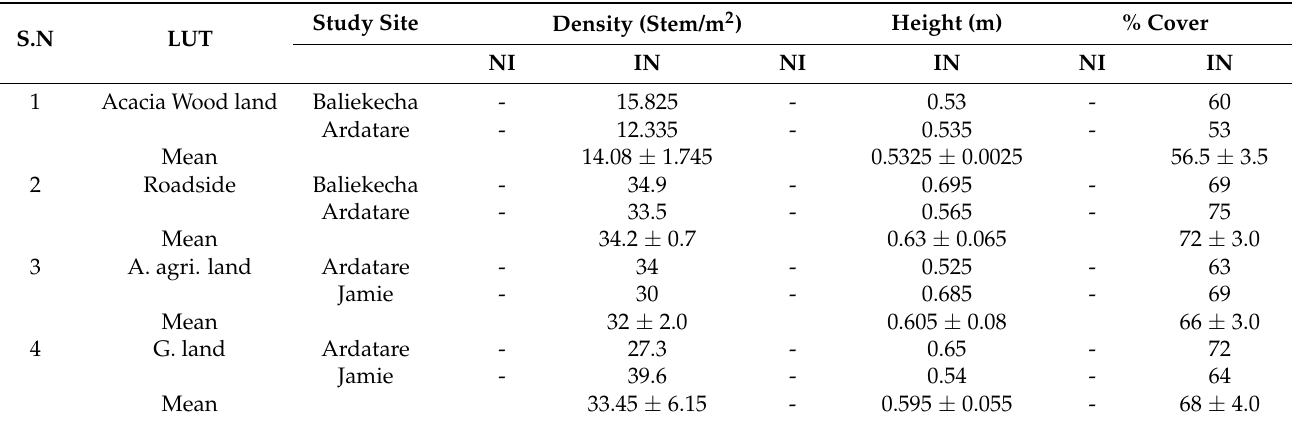
Table 3. Mean of P. hysterophorus density, height, and percentage cover in invaded and non-invaded land unit in Ginir district, southeastern